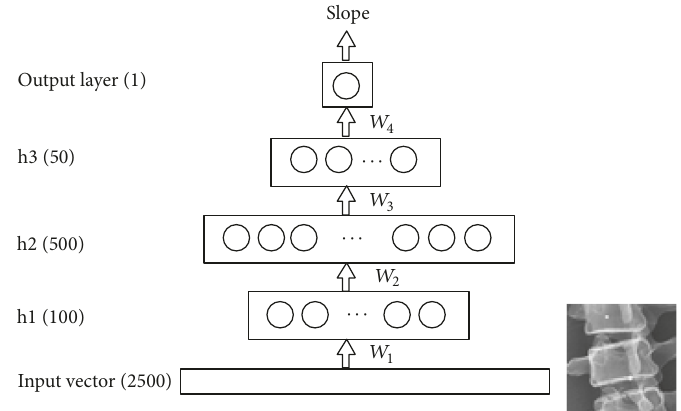
Figure 2: Architecture of the proposed network.